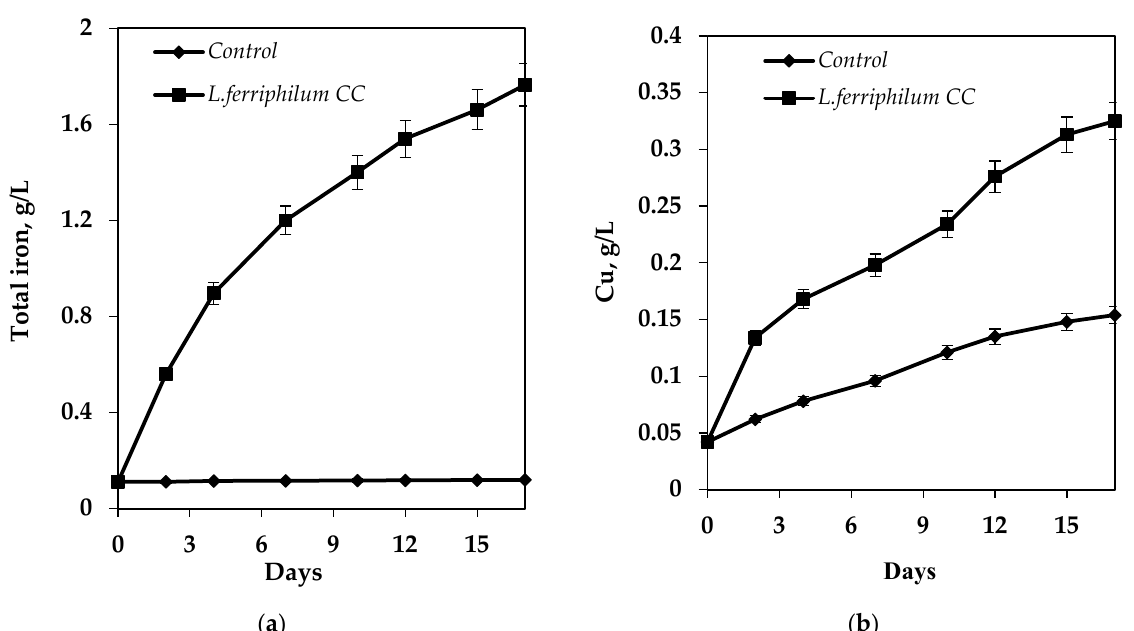
Figure 5. Bioleaching of iron ( a ) and copper ( b ) from chalcopyrite by L. ferriphilum CC (T 40 °C; pH 1.5, PD 4%).